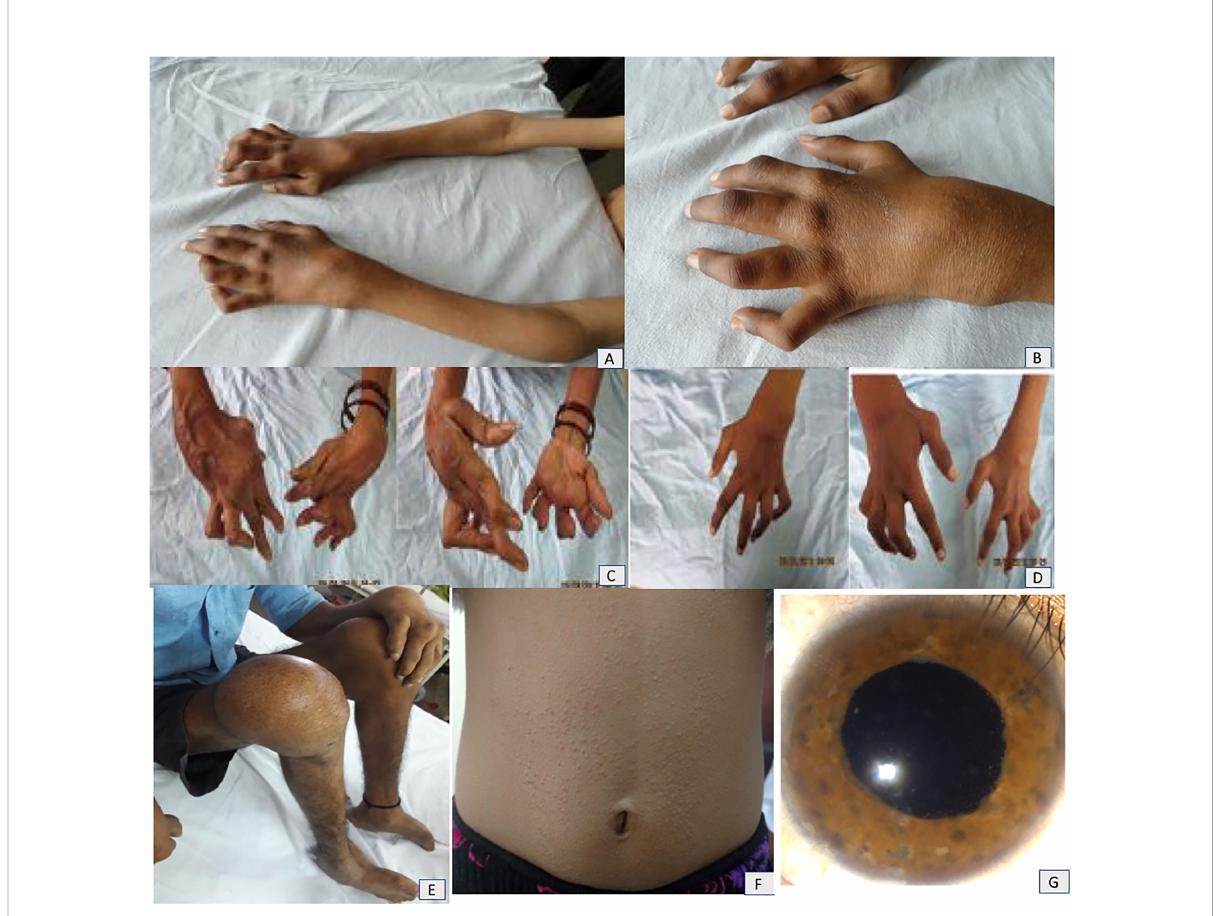
FIGURE 1 (A, B) Boggy swelling of wrist, elbow, and small joints of hands and camptodactyly in patient no. 7. Mother (C) and elder sister (D) of patient no. 7 showing extreme deformities of small joints of hands. (E) Residual joint deformities of bilateral foot and knee as well as small joints of hands in patient no. 11. (F) Micropapular rash on trunk in patient no. 10. (G) Anterior segment photograph of a patient with Blau syndrome shows presence of iris nodules, anterior chamber cells, and fl are suggestive of chronic anterior